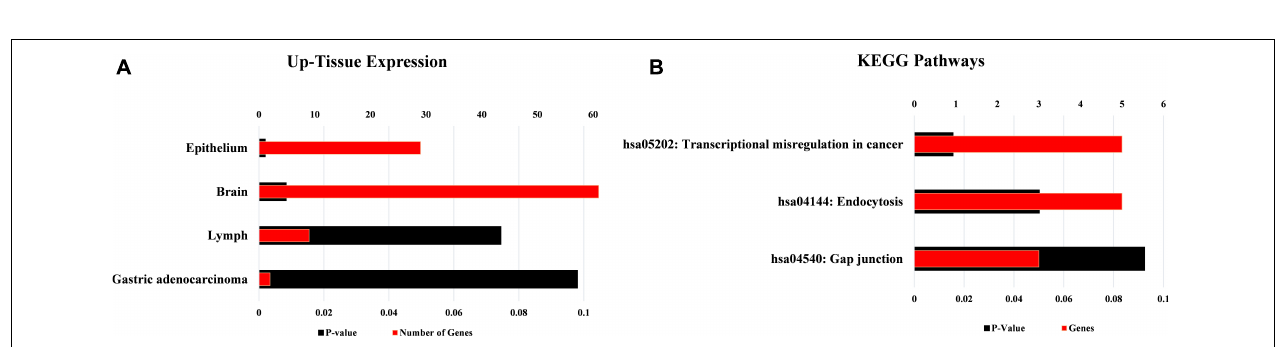
FIGURE 6 | The GO annotations for biological process, molecular function, and cellular component of the predicted mRNAs regulated by both scrutinized circRNAs. The GO annotations along with the number of genes and P -value are also mentioned in the chart. The lowest p -value is utilized for sorting the GO terms in the figure.